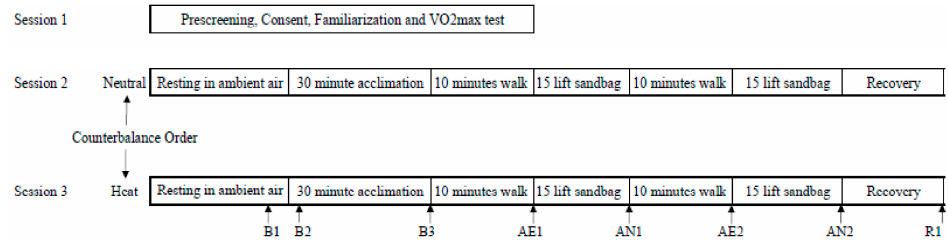
Figure 1. Experimental design and timeline. B1, baseline; B2, second baseline; B3, third baseline, AE1,